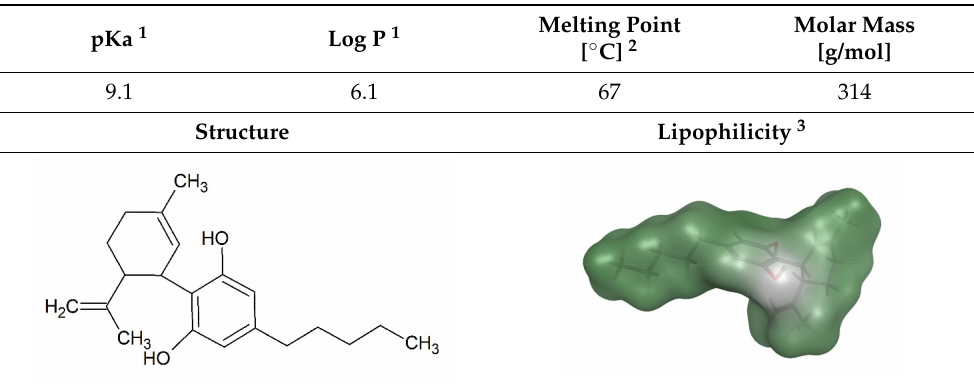
Table 1. Structure and physicochemical properties of cannabidiol; green areas represent a lipophilic surface whereas grey areas are neutral and purple areas are